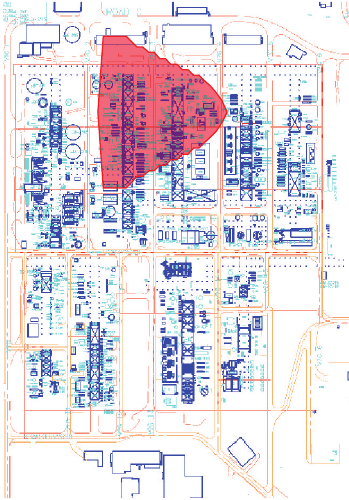
Figure 15: Structural damage using SLAM threshold values for scenario 2:T2302.